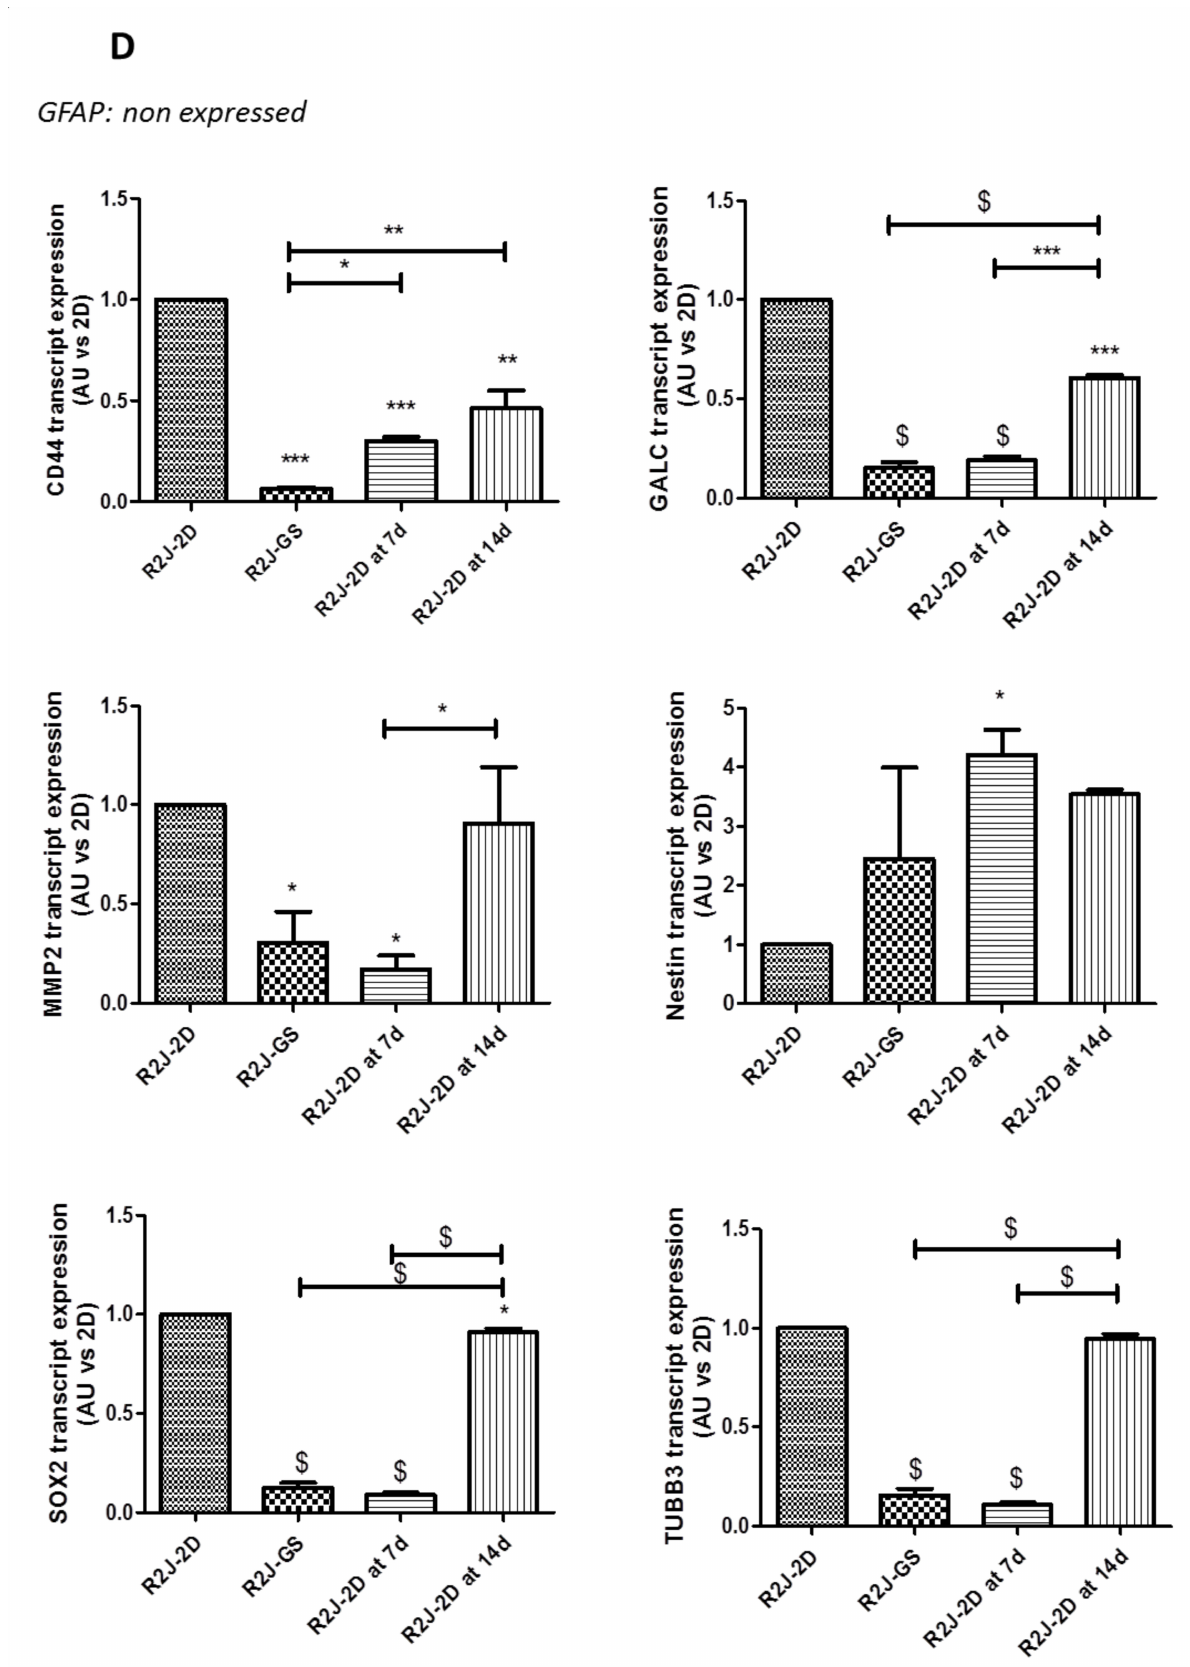
Figure 1. R2J cells were plated in monolayer ( A ) in serum-enriched medium (10%) at 6000 cells/cm 2 , harvested, and